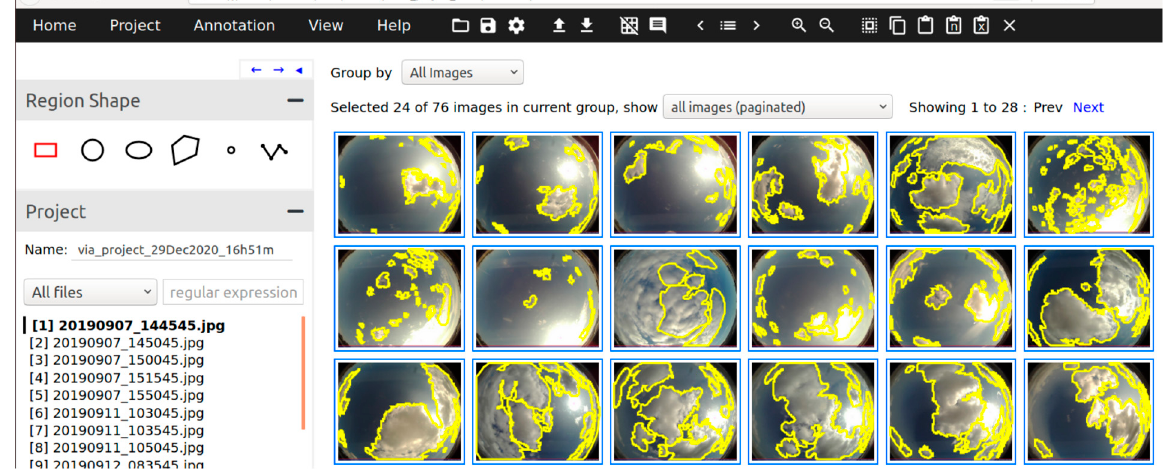
Figure 7. Annotated clouds for training.